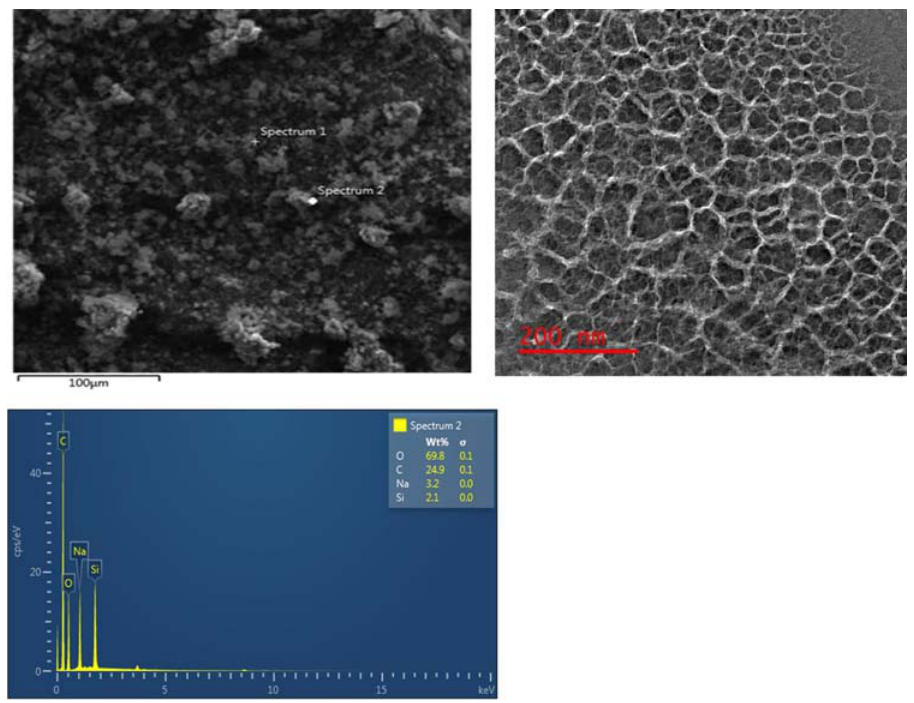
Figure 1: SEM ( left ) , TEM ( right ) and EDS ( bottom ) images for mesoporous